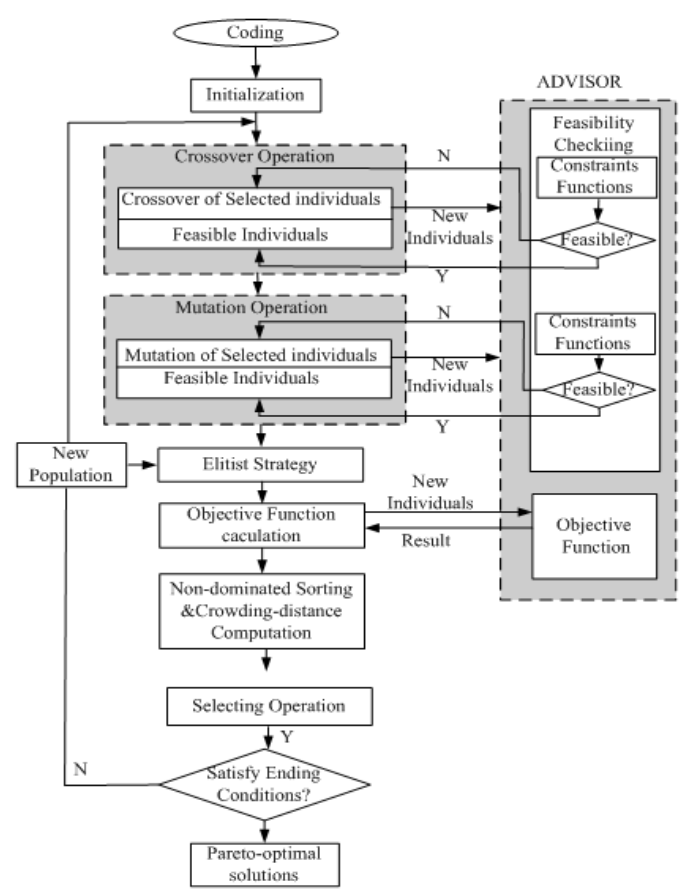
Figure 6. The iterative process of the